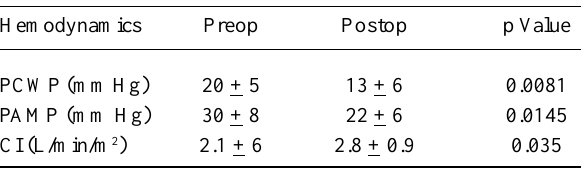
Table 1. Hemodynamics variable comparison between preop and postop values